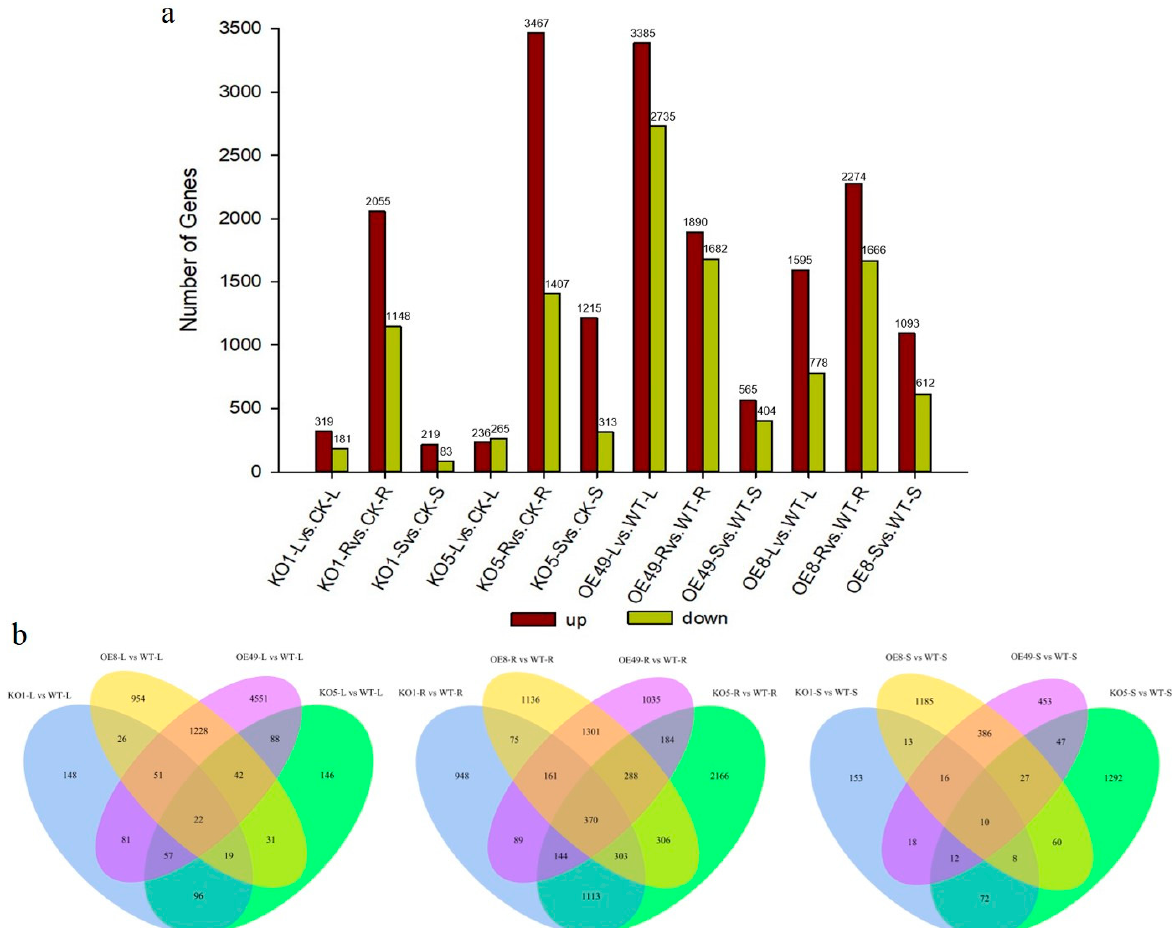
Figure 5. Statistical analysis of all DEGs identified in the leaves (L), stems (S), and roots (R) of KO1, KO5, OE49, and OE8. ( a ) Statistical analysis of the number of up-regulated (up) and down-regulated (down) DEGs. ( b ). Venn diagrams showing the distribution of DEGs.